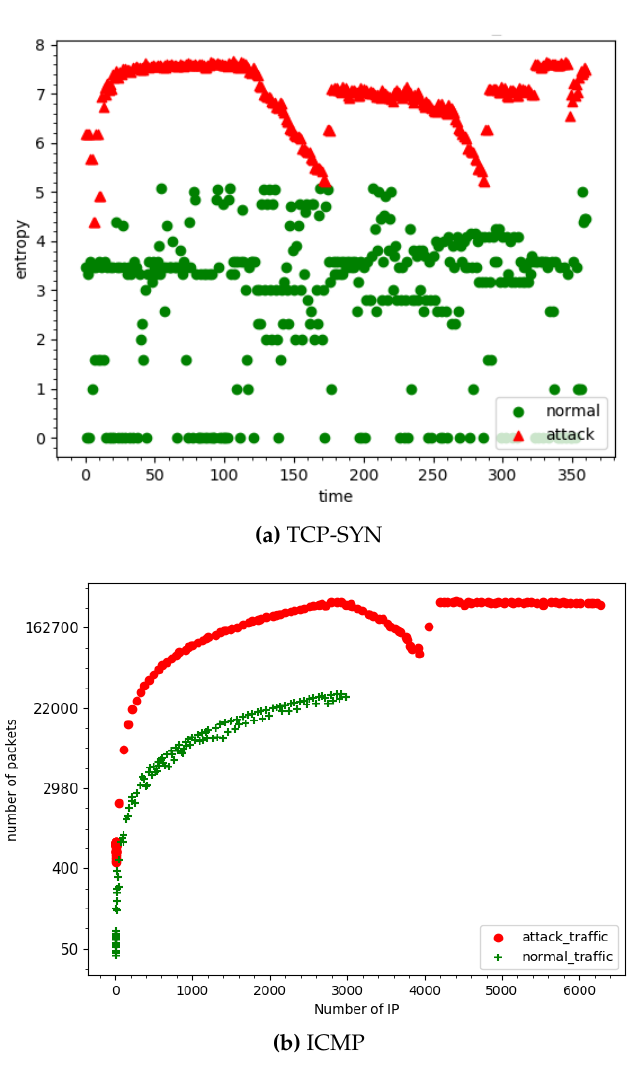
Figure 3. ( a ) Average entropy of source ports per each IP address; ( b ) Logarithm of number of ICMP packets per each IP